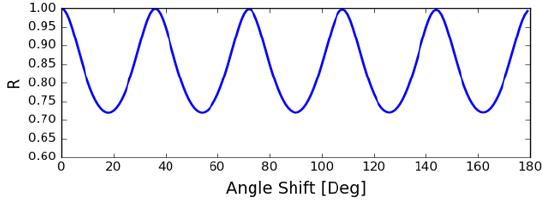
Figure 3: Circular autocorrelation of polar shape matrix.